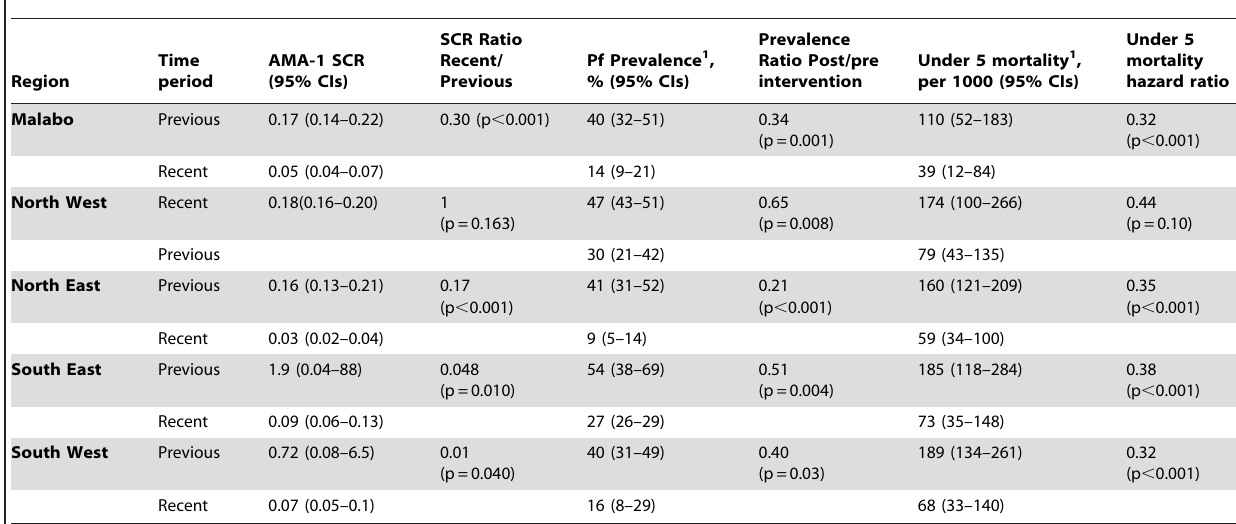
Table 3. Heterogeneity in reductions in transmission: Changes in seroconversion rates for anti P.falciparum AMA-1 antibody responses, in P.falciparum prevalence and in under five mortality before and after interventions by region.